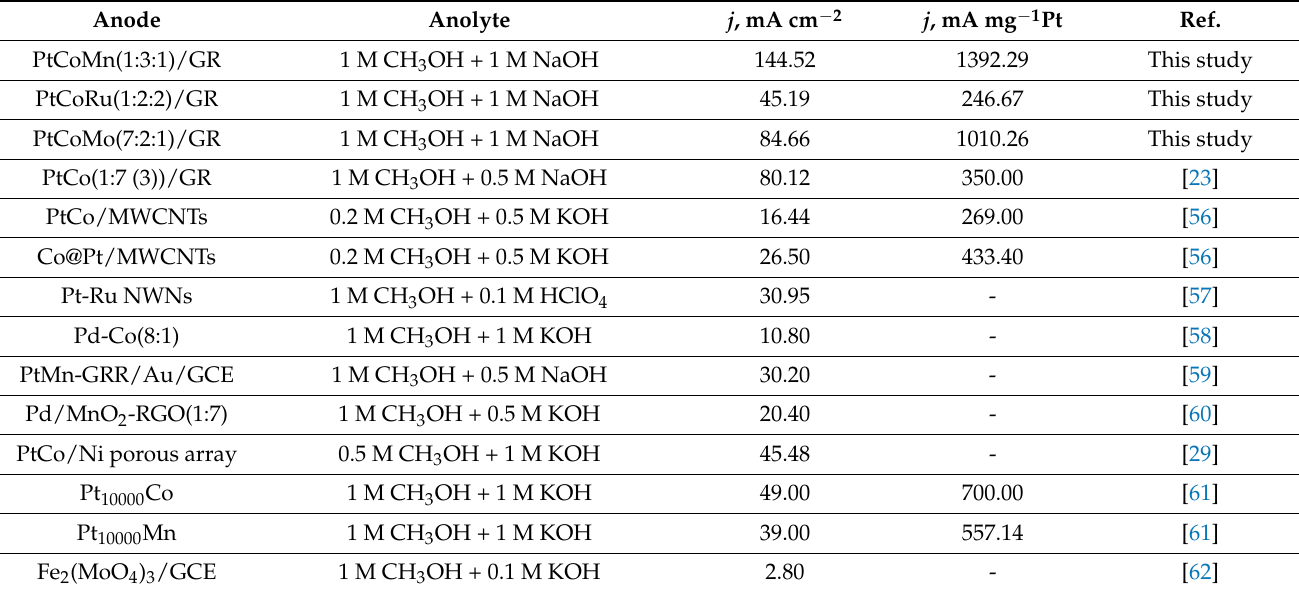
Table 2. The comparison of methanol oxidation current densities obtained for various catalysts presented in the literature and this